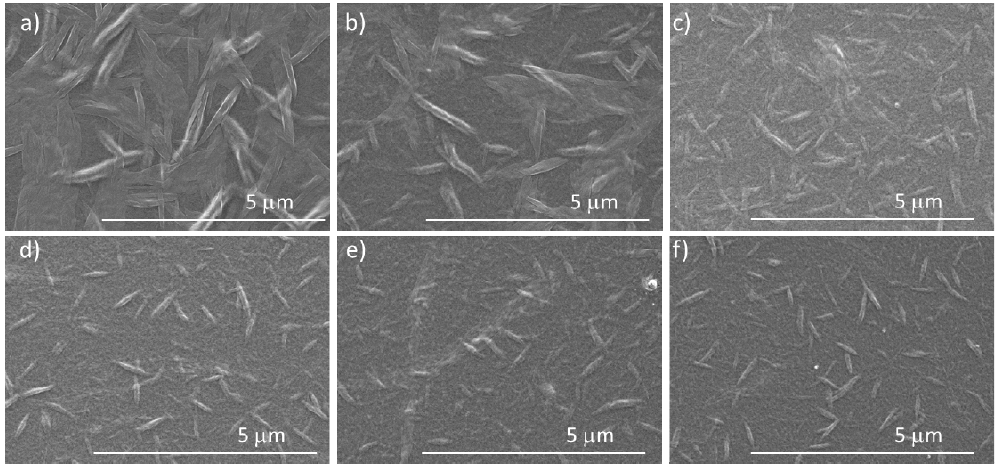
Figure 2. SEM images of PBTTT-C 14 :PDI8-CN 2 BHJ films obtained by spin-coating from a 100 °C hot solution at rotation speeds of ( a ) 1000 rpm, ( b ) 2000 rpm, ( c ) 3000 rpm, ( d ) 4000 rpm, ( e ) 5000 rpm, ( f ) 6000 rpm.